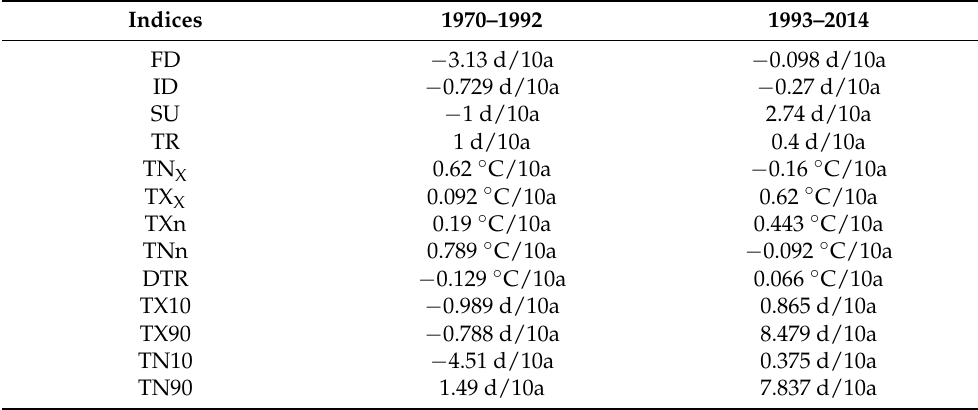
Table 4. The trend change of 13 extreme temperature indices was affected by urbanization in two different periods.